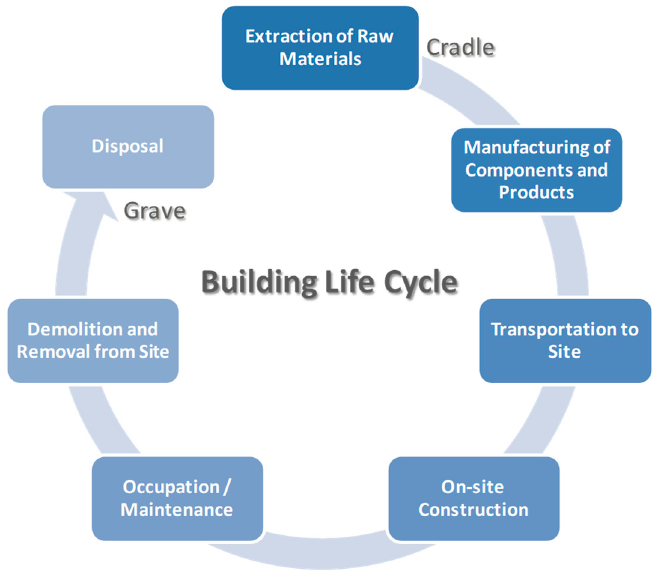
Figure 1. Life cycle process of a building.